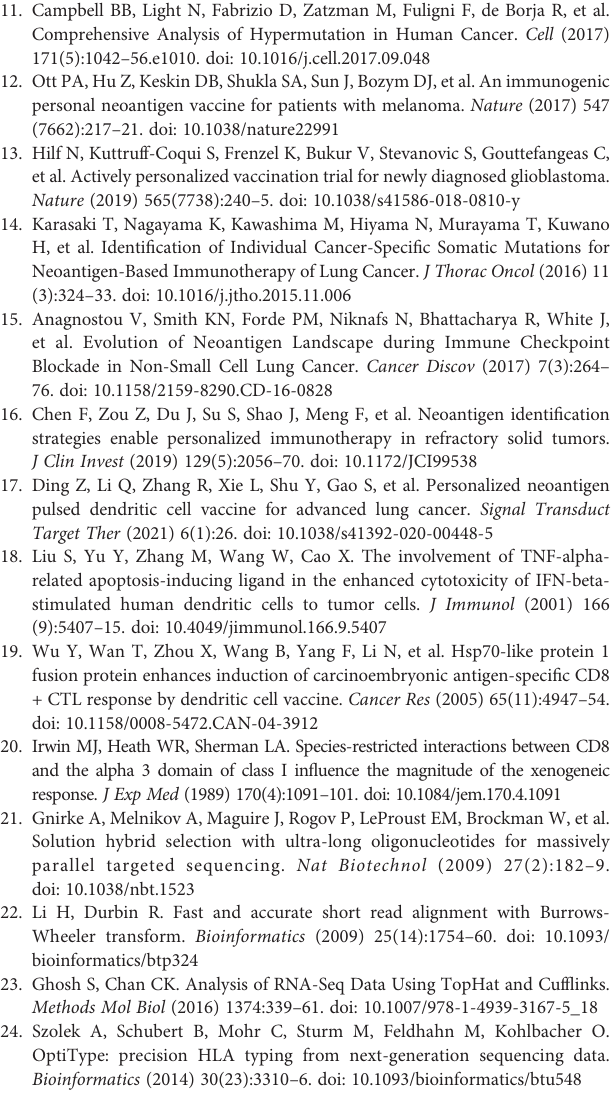
Supplementary Figure 1 | Immunogenicity of Cancer-associated mutations in HLA-A2.1/KbTg mice. Splenocytes of mice vaccinated with peptides and polyinosinic: polycytidylic acid (polyI: C) were tested for recognition of mutated peptides by fl ow cytometry. Supplementary Figure 2 | Expression of HLA-A * 0201/Kb chimeric gene in T2/ Kb and H522/Kb cells. T2/Kb and H522/Kb cells were stable transfectants and express the product of the HLA-A * 0201/Kb chimeric gene (the a 1 and a 2 domains from HLA-A * 0201 and the a 3 domain of H-2Kb) Supplementary Figure 3 | Immunogenicity of peptides-containing neoantigen at different various concentrations. Peptide titration of the NRT lines speci fi c for PLACG1-M425L, BCAR1-G23V and ACAD8-T105I peptides. The immune splenocytes from HLA-0201/Kb vaccinated animals were stimulated with various concentrations (100, 10 or 1 m M) of PLACG1-M425L, BCAR1-G23V and ACAD8- T105I peptides. After 4 h of incubation, frequency of IFN- g -secreting cells was measured. The data are presented as the means ± s.e.m.s from three independent